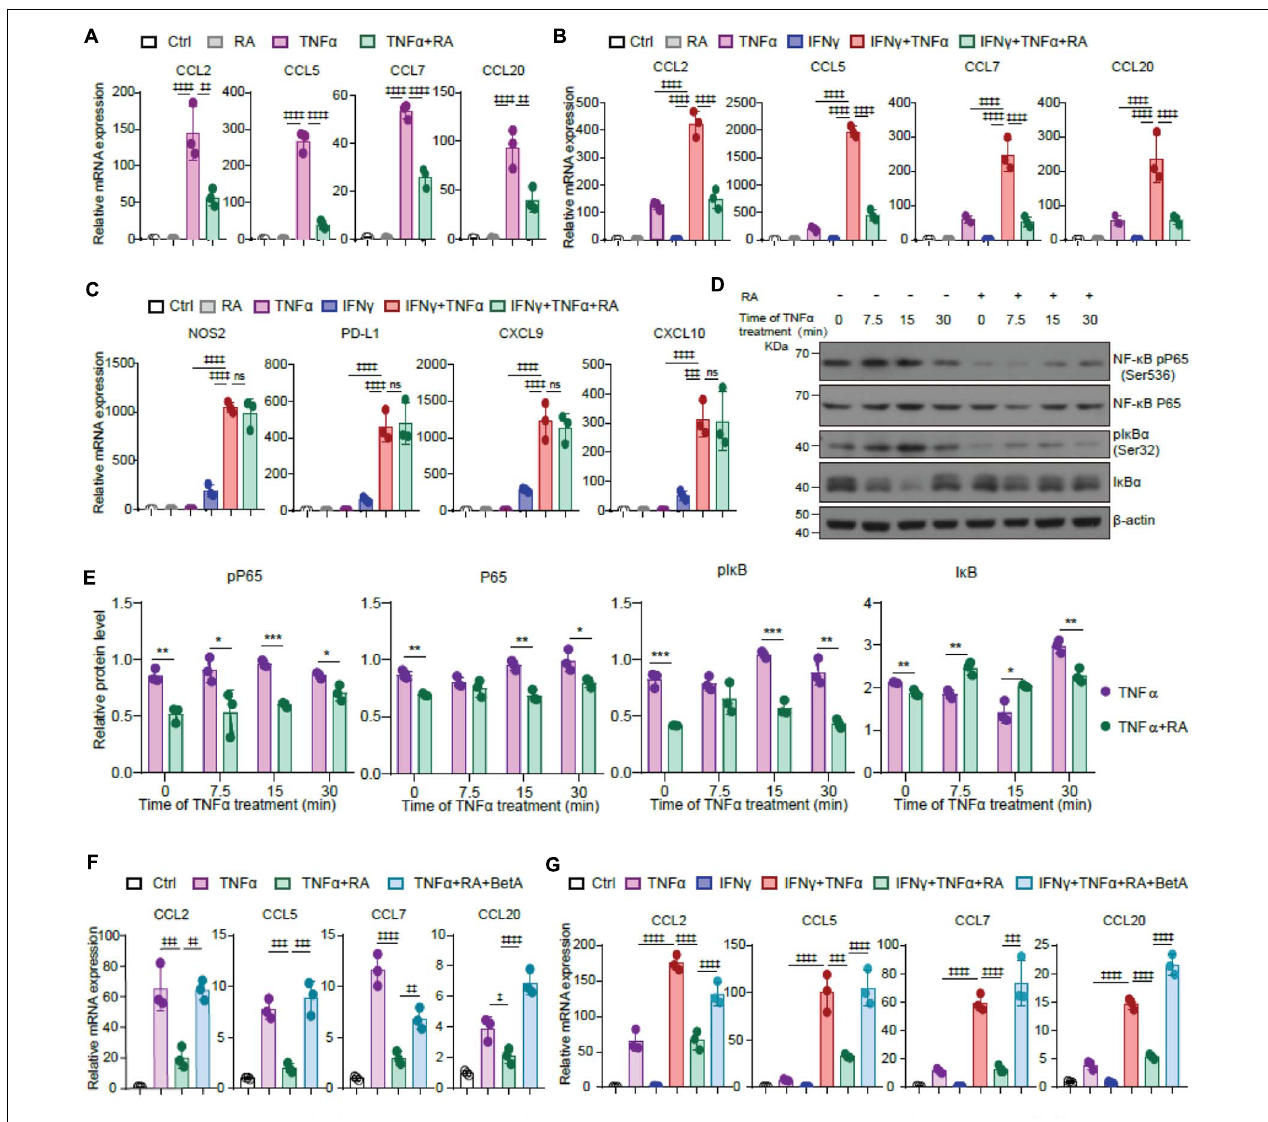
FIGURE 5 | RA inhibits TNF α mediated chemokine expression in TA-MSCs by blocking NF- κ B signaling pathway. (A) The mRNA expression of myelocyte-recruiting chemokines (CCL2, CCL5, CCL7, and CCL20) in BMSCs treated with TNF α and RA as indicated. (B,C) The relative mRNA expression of myelocyte-recruiting chemokines (B) and immunoregulatory molecules (NOS2, PD-L1, CXCL9, and CXCL10) (C) in the TNF α and IFN γ treated BMSCs with or without the RA treatment as indicated. (D,E) Immunoblotting analysis of NF- κ B RelA p65, I κ Ba, and pI κ Ba (Ser32) in the BMSCs exposed to TNF α and RA as indicated. (F) The relative mRNA expression of myelocyte-recruiting chemokines in BMSCs treated by TNF α and RA with or without the BetA as indicated. (G) The relative mRNA expression of myelocyte-recruiting chemokines in BMSCs treated by IFN γ , TNF α , RA, and BetA as indicated. Data represent mean ± SD of 3 independent experiments. ∗ p < 0.05, ∗∗ or ‡‡ p < 0.01, ∗∗∗ or ‡‡‡ p < 0.001, ‡‡‡‡ p < 0.0001. ns, not